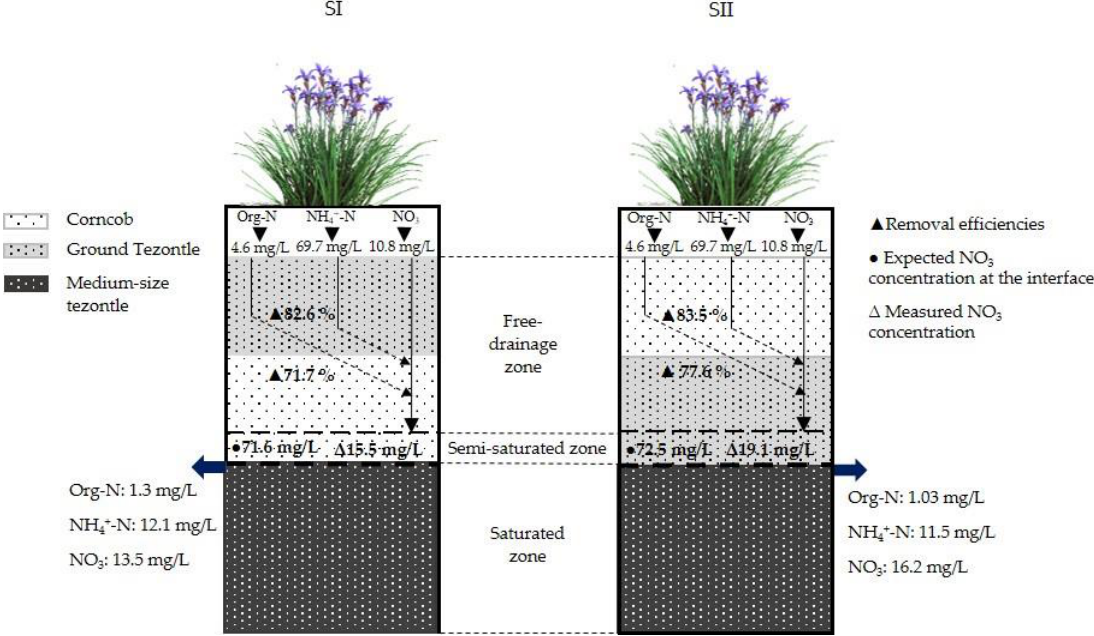
Figure 13. Theoretical generation of nitrate: Difference between expected concentrations through full nitrification and measured concentrations.